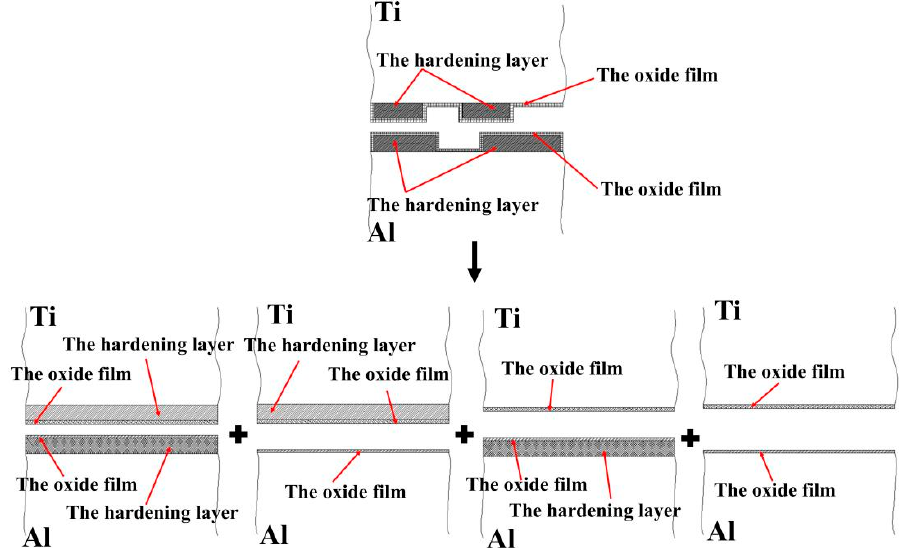
Figure 26. Equivalent contact model of the facing surfaces of the Ti/Al clad.